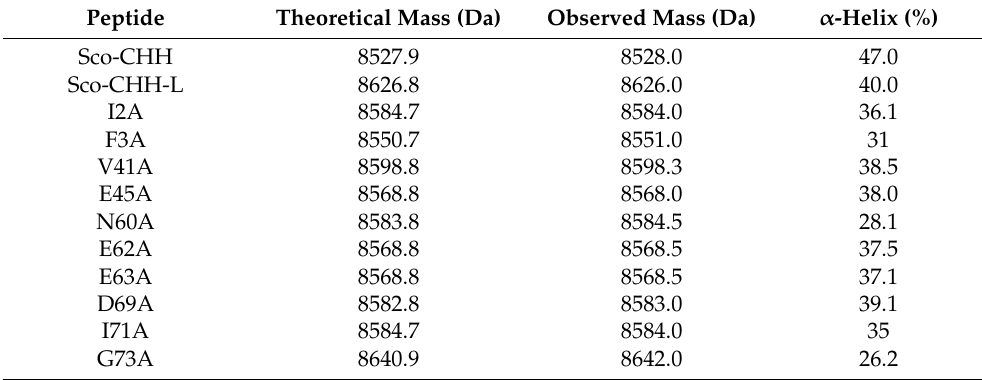
Table 1. Identification and characterization of recombinant wild-type and alanine-substituted peptides.